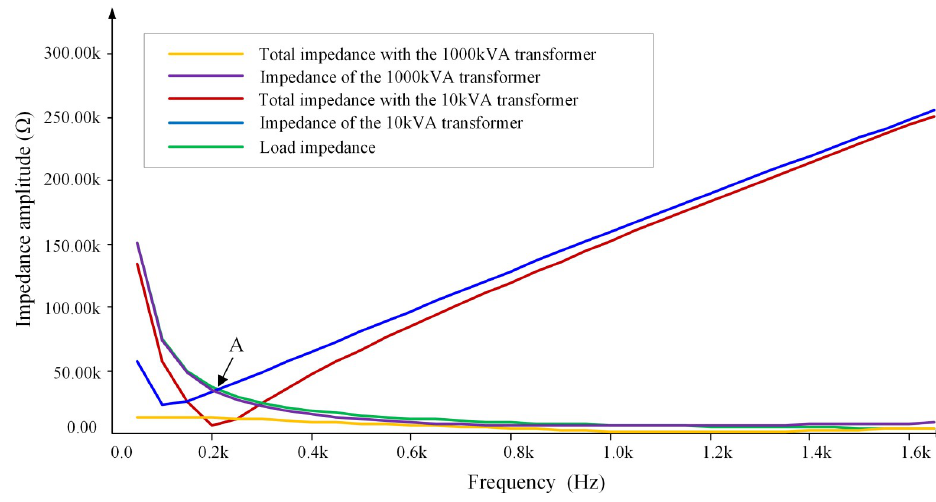
Fig 12. Impendence-frequency characteristics of the experimental platform circuit.